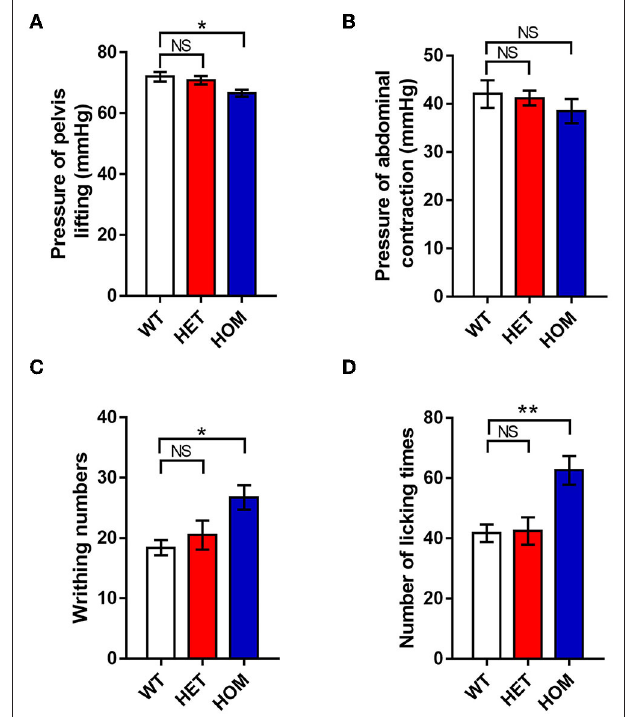
FIGURE 3 | The visceral pain thresholds in different genotypes. (A,B) AWR test. The minimum thresholds of colorectal distention pressures were recorded when mice lifted the abdomen and pelvic structures. (C) Acetic acid-induced writhing test. The number of writhing actions (contractions of the abdominal muscles, accompanied by stretching) was counted in 20min after intraperitoneal injection with acetic acid. (D) Formalin-induced visceral nociception test. The number of abdomen-licking behaviors was observed for 60min after instilling formalin into the colon. Data were presented as the mean ± SEM. Significance was tested with one-way ANOVA followed by Dunnett’s multiple comparisons test. * p < 0.05 and ** p < 0.01 vs. WT mice. NS, no significance; WT, wild-type ( Scn11a + / + mice); HET, heterozygote ( Scn11a + / R222S mice); HOM, homozygote ( Scn11a R222S / R222S mice).